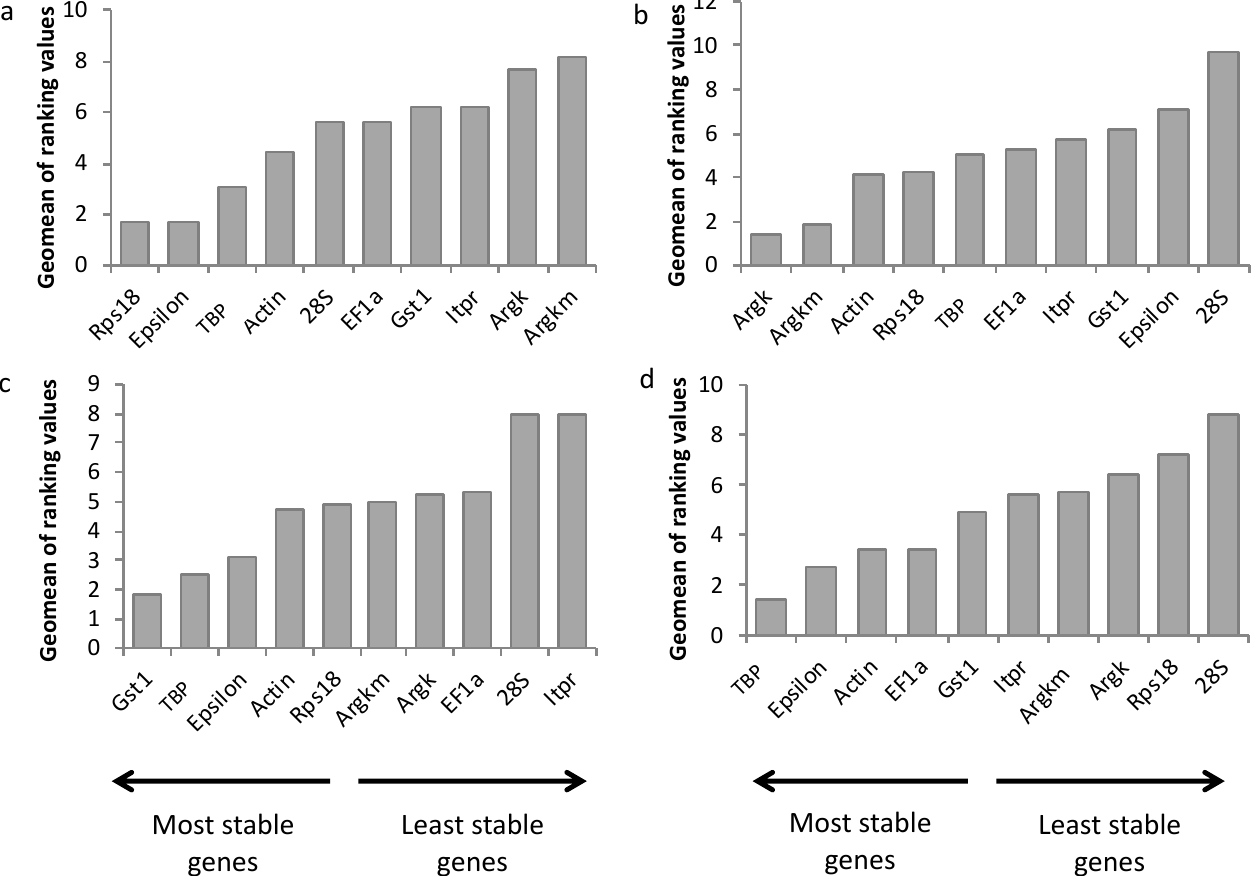
Fig 1. Stability values (Geomean ranking values) of 9 reference genes according to RefFinder. The most stable genes, those with lower values, are listed on the left and the least stable genes on the right. (a) larvae, (b) pupae, (c) adult (abdomen of females) and (d) all of individuals combined. Epsilon = 14-3-3 epsilon ; Argkm =